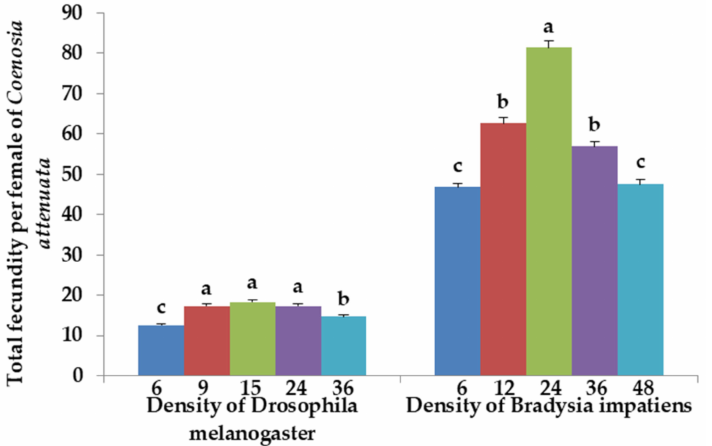
Figure 5. Total fecundity per female of C. attenuata when fed 6, 9, 15, 24 and 36 adults of D. melanogaster and 6, 12, 24, 36 and 48 adults of B. impatiens daily per predator adult. Differ- ent letters above each bar indicate significant differences between prey densities (corrected p value for multiple testing by Bonferroni correction is 0.005 and n =